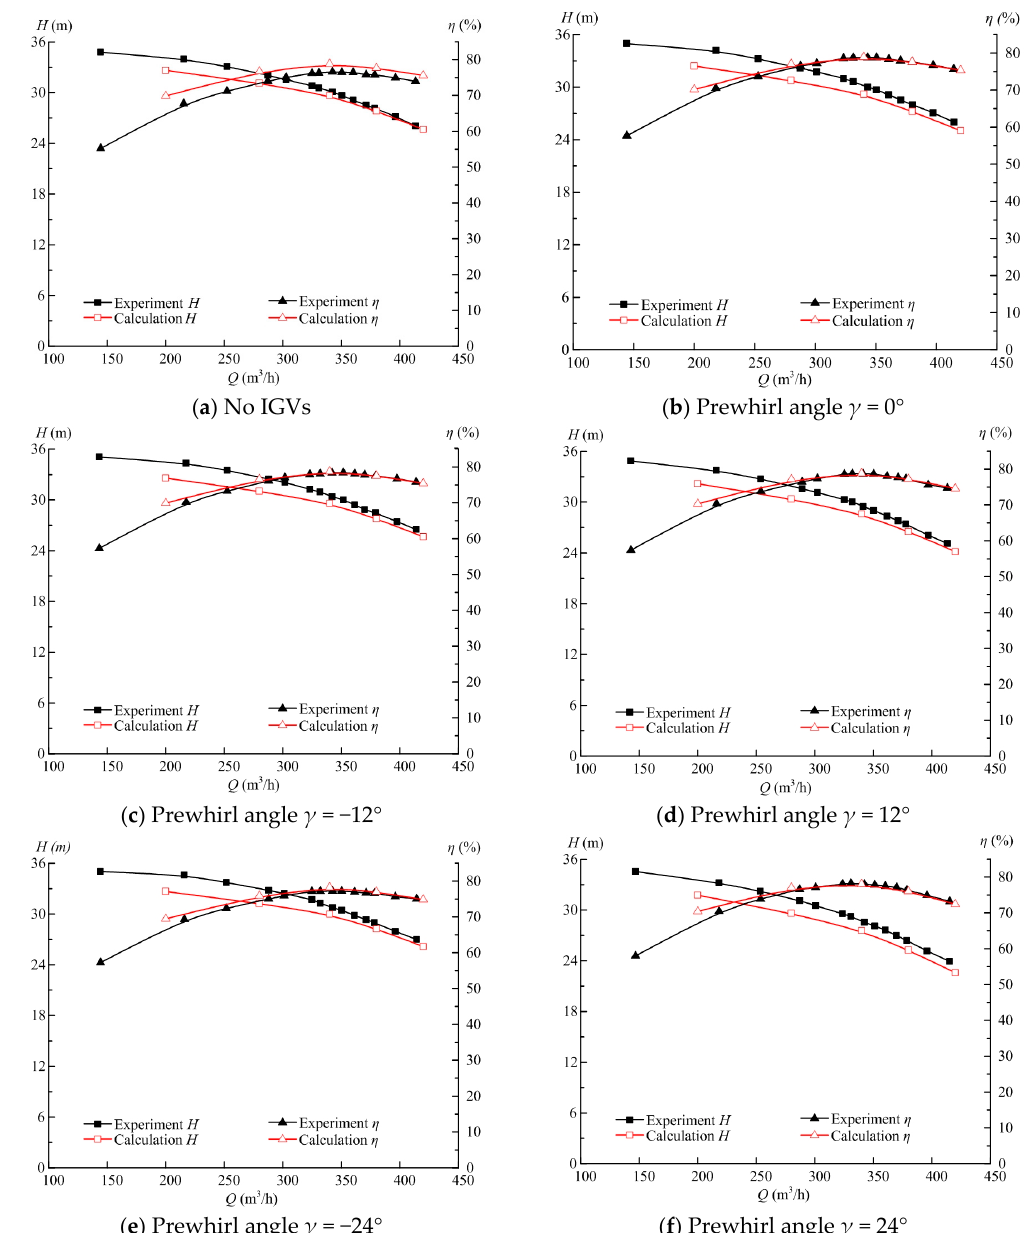
Figure 4 . Comparison of pump performance between the experimental and simulation results. Figure 4. Comparison of pump performance between the experimental and simulation